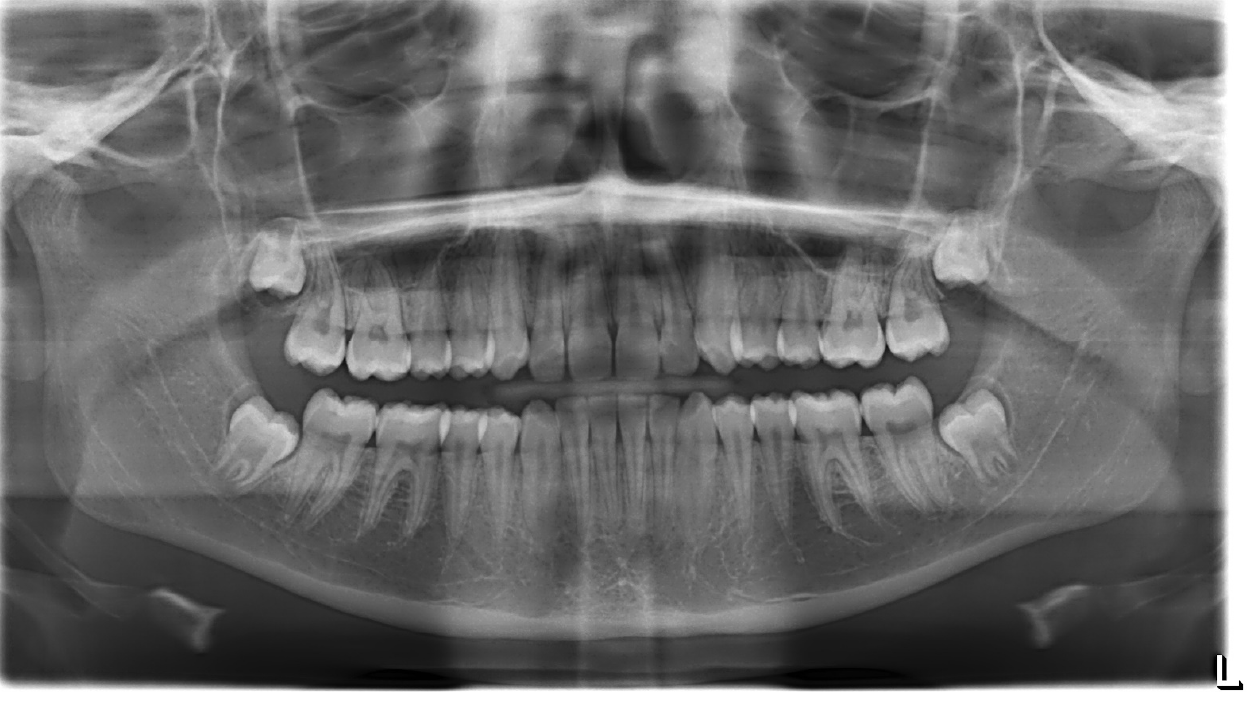
Figure 10. Radiographs of the subject at the end of the treatment. Orthopantomography X-ray after treatment and a 3-year follow-up period (14-year-old).